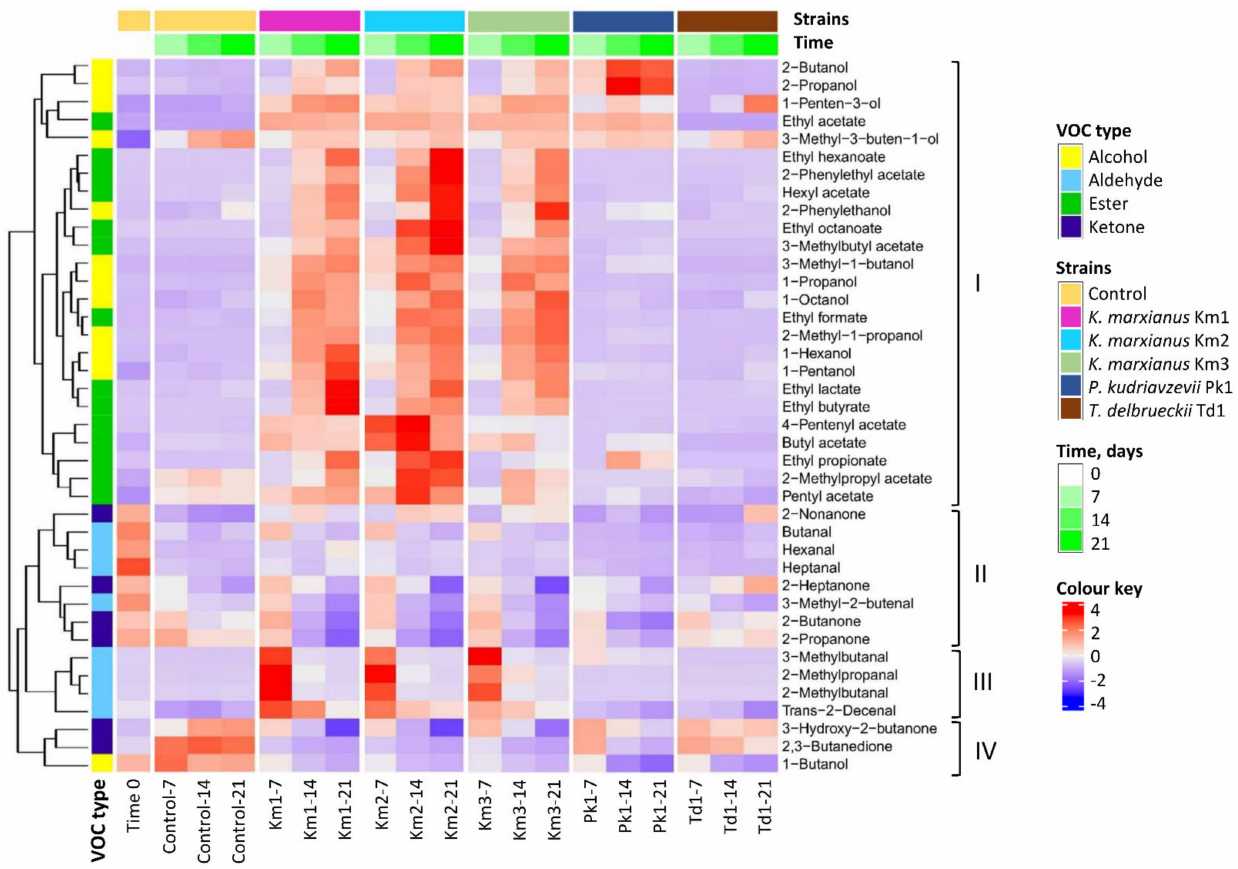
Figure 4. Hierarchical cluster analysis (Pearson’s correlation) and a heat map of VOC profiles shown in relation to yeast strains and incubation time. VOCs were determined during growth of yeasts K . marxianus (strains Km1, Km2 and Km3), P. kudriavzevii Pk1 and T. delbrueckii Td1 in skyr at 8 ◦ C for 21 days and in controls (skyr without yeasts). Sample codes denote the strain ID and the incubation period (0, 7, 14 and 21 days). Heat map was constructed using mean values from